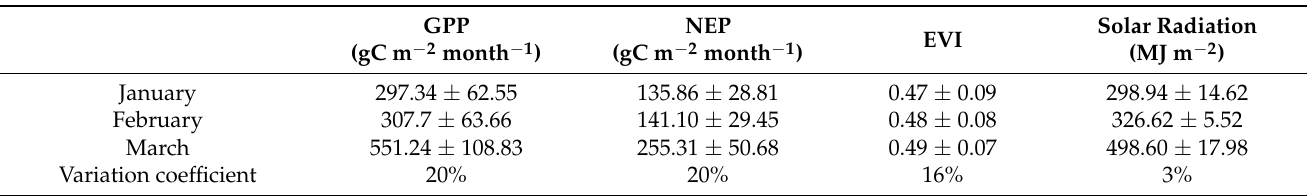
Figure 2. The betel nuts GPP spatial variability in the area of Chiayi County, Taiwan. Table 2. GPP, NEP, EVI, and Solar radiation means and variation coefficients during the detection period in